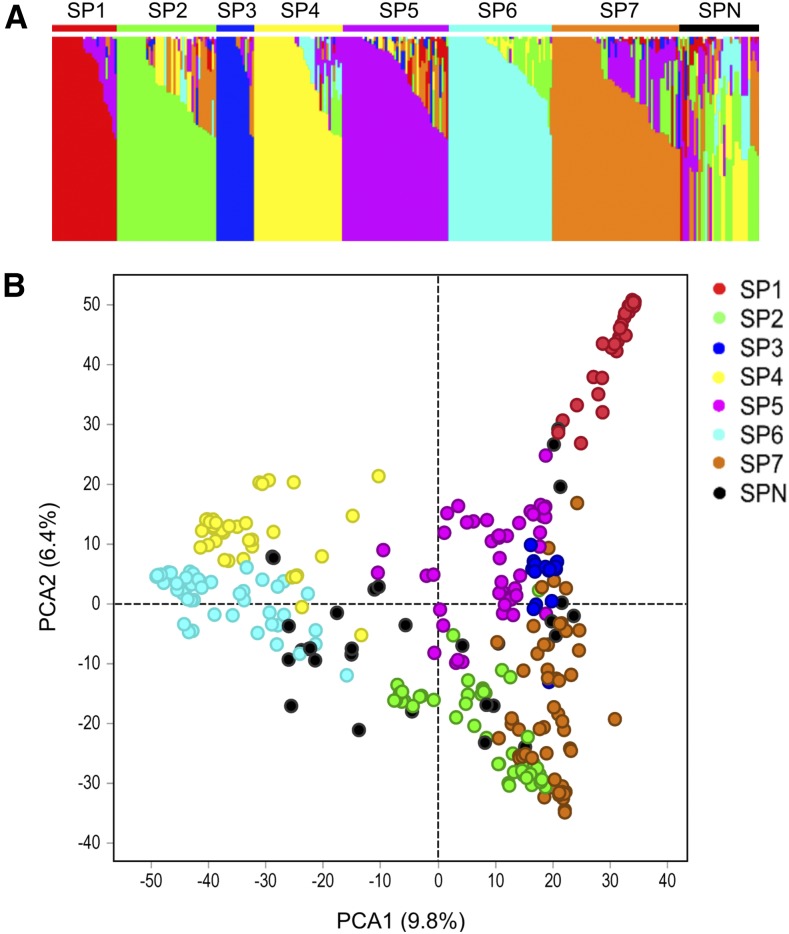
(A) Population structure of the WBDC inferred from Bayesian grouping implemented in STRUCTURE where the number of subpopulations (SP) identified was seven. (B) PCA of the WBDC identified seven major groups that corresponded closely with the subpopulation assignment results found with STRUCTURE analysis. Accessions not belonging to any of the seven subpopulations are shown in black.